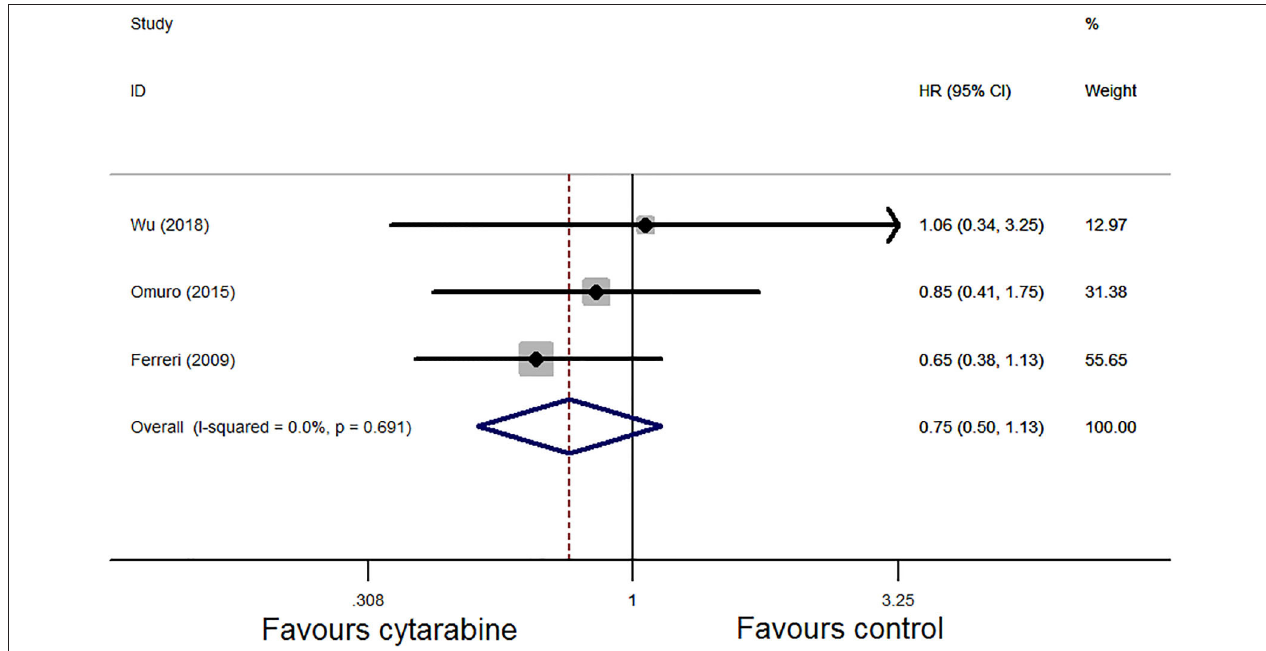
FIGURE 5 | Forest plot of overall survival for treatment with the cytarabine group vs. the cytarabine-free group (fixed effect model). HR is the effect